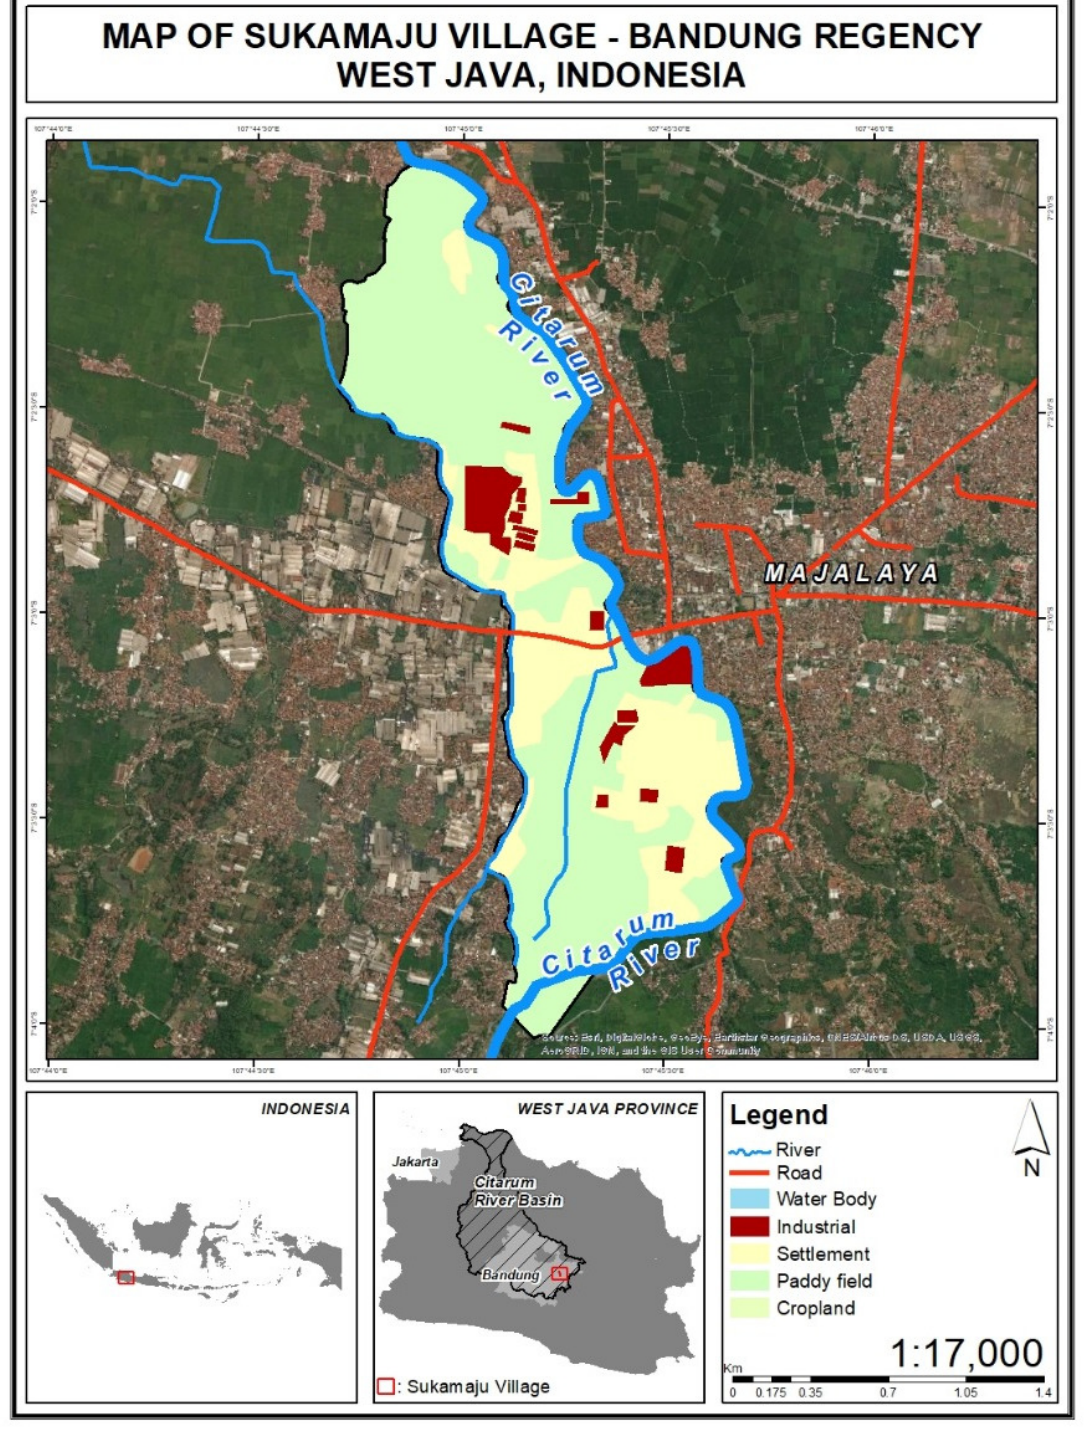
Figure 2. The map of Sukamaju Village, Bandung Regency, West Java,